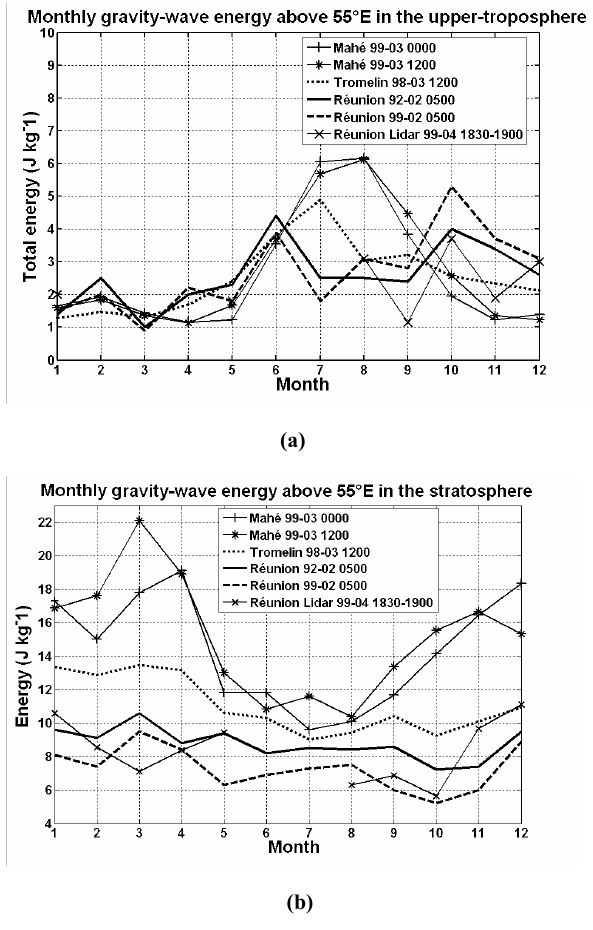
Fig. 3. (a) Estimated monthly-mean wave energy density from radiosonde measurements in the upper troposphere above Mah´e at 00:00 UT and 12:00 UT, Tromelin at 12:00 UT and R´eunion at 05:00 UT and from Raman lidar data above La R´eunion at 18:30 UT–19:00 UT. (b) Same as panel (a) but for the LS.